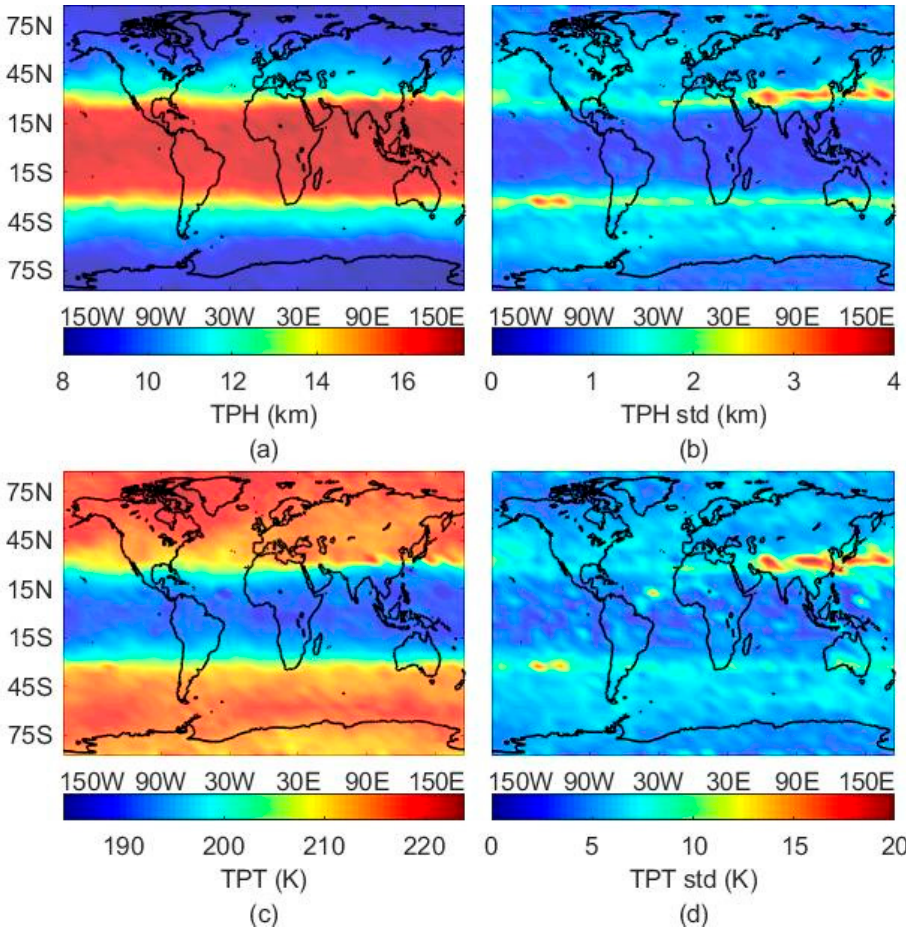
Figure 9. Seasonal patterns of TPT and TPH derived from January 2014-December 2017 FY-3C data. This is for spring (March, April, May). The ( a ) panel is global TPH pattern and the ( b ) panel is for the standard deviation of global TPH. Similarly, the ( c ) panel and the ( d ) panel are for global TPT pattern and TPT standard deviation, respectively.